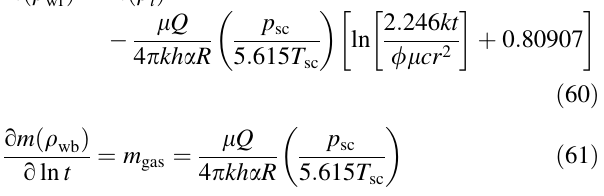
Figure 2 shows example of the specialised semi-log plot of fluid densities versus time (Horner/Agarwal time, Horner 1951; Agarwal et al. 1970) for permeability estimation, and Fig. 3 depicts the expected density derivatives for each fluid phase generated from Horne (1995) and Biu and Zheng (2015). The logarithm density derivative function can be expressed